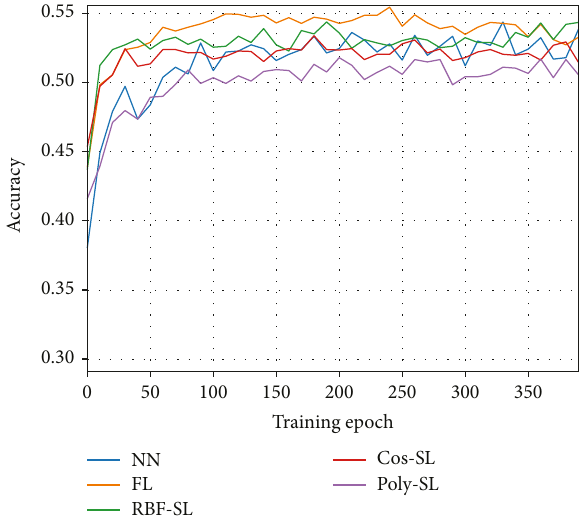
Figure 6: Classi fi cation performance on LastFM